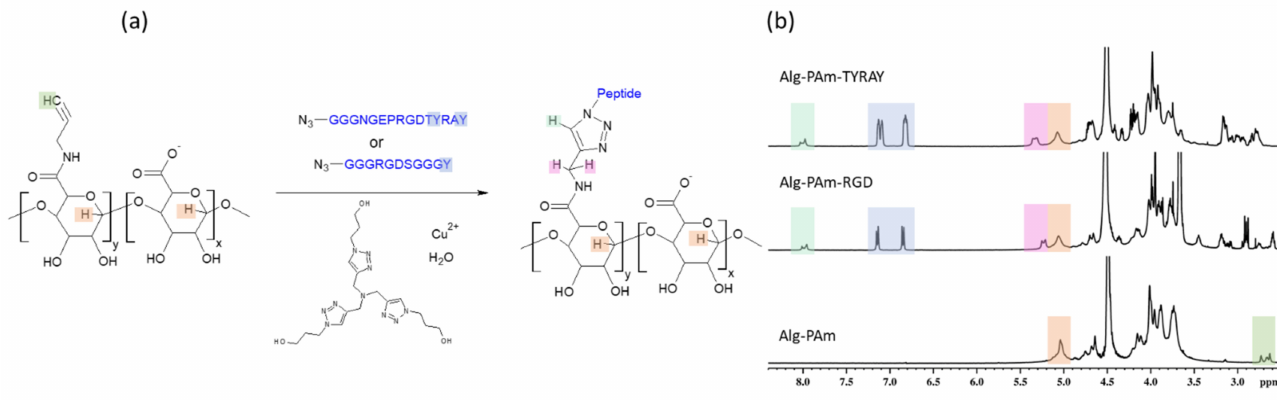
Figure 8. Peptide conjugation to alginate with help of CuAAC. ( a ) scheme of the reaction; ( b ) 1 H NMR spectrum of Alg-PAm measured in D 2 O at 50 ◦ C (bottom); 1 H NMR spectrum of Alg-PAm-RGD measured in D 2 O at 50 ◦ C (middle); 1 H NMR spectrum of Alg-PAm-TYRAY measured in D 2 O at 50 ◦ C (top). Hydrogens assigned to the specific signals are marked with